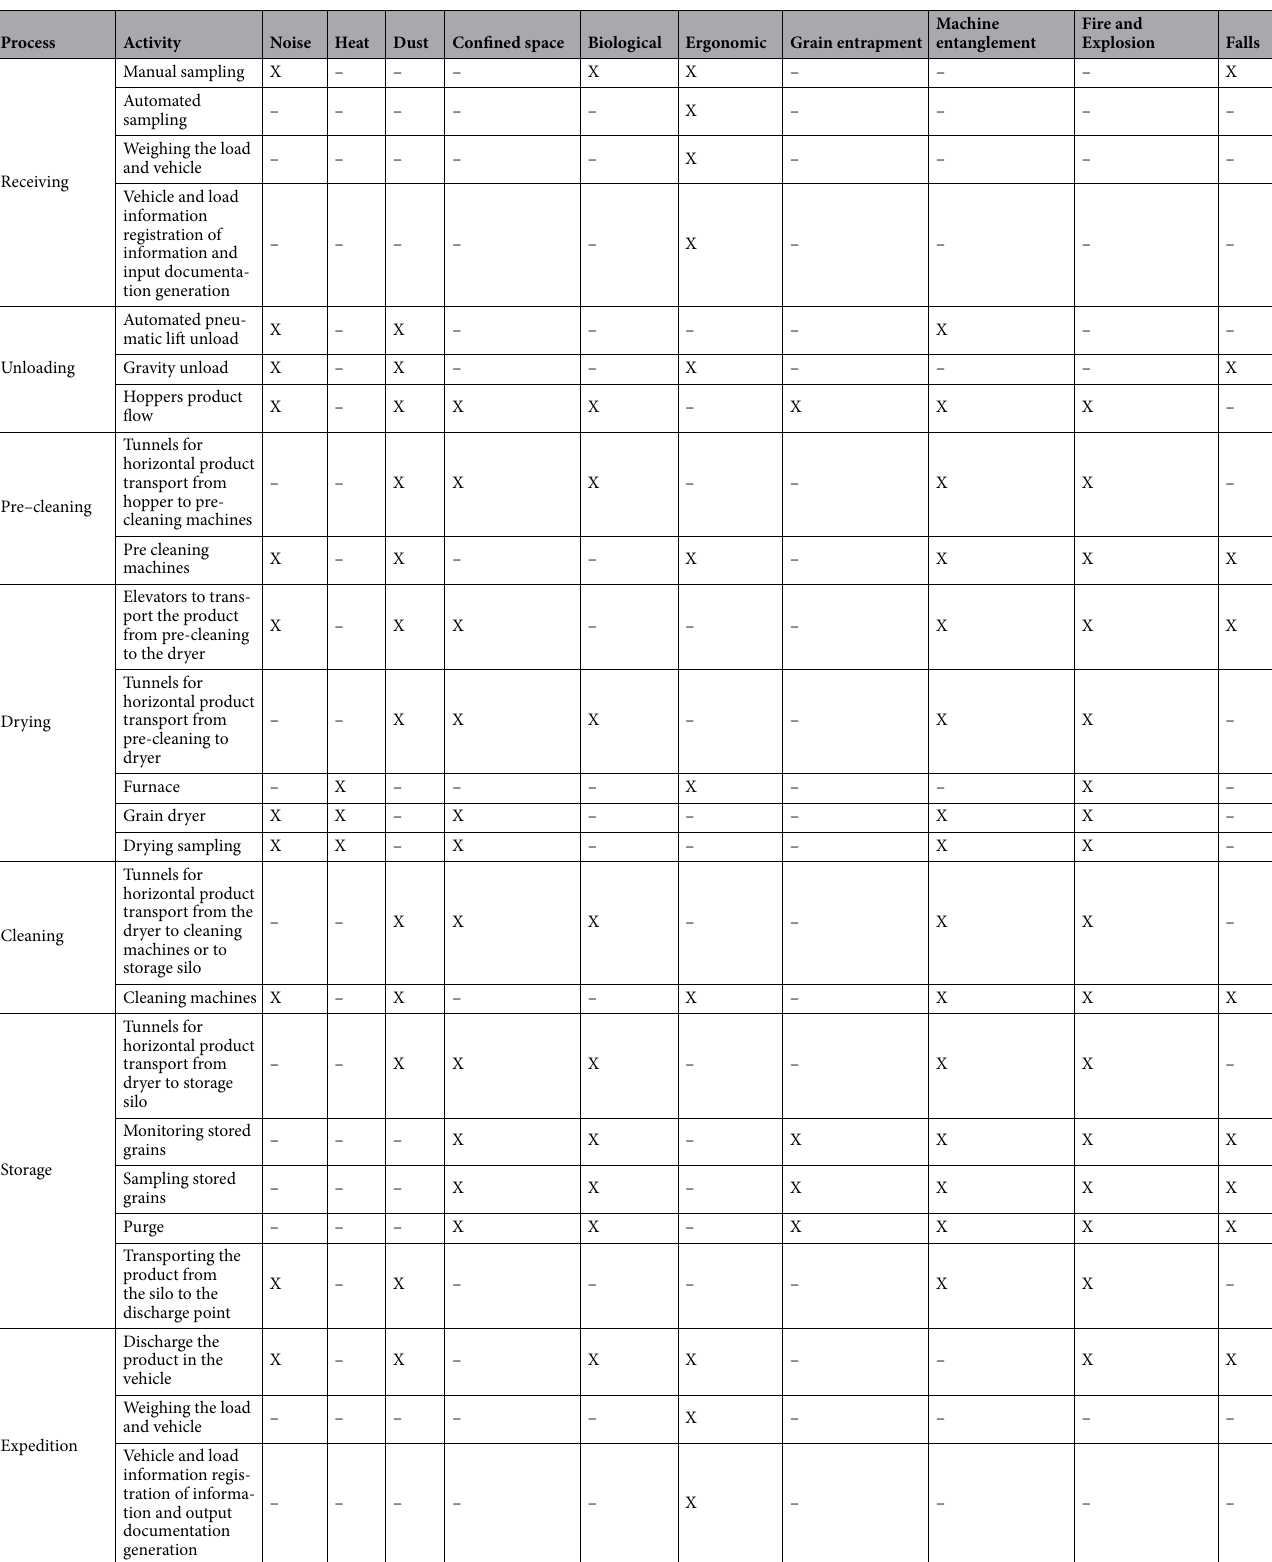
Table 1. Occupational hazards at grain handling and storage facilities by process and